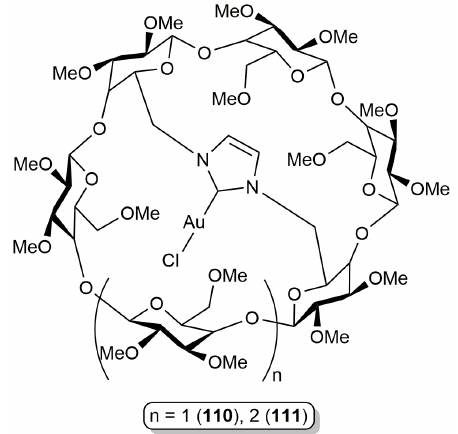
Figure 8. Structure of the NHC-Au(I) complexes 110 and 111 .